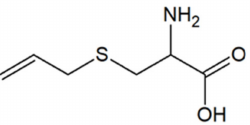
Figure 1. Structure of S -allyl